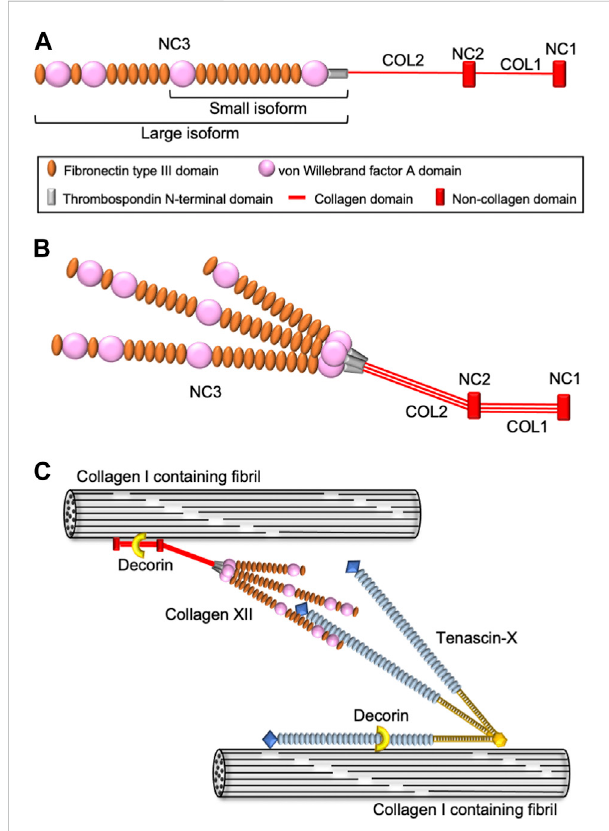
FIGURE 1 Schematic diagram of collagen XII structure and molecular interactions. (A) DomainstructureofcollagenXII.CollagenXIIconsists of two short triple helical domains (COL1 and COL2) separated by non-collagenous domains (NC1 and NC2) and large amino- terminal non-collagenous domains (NC3). NC3 is composed of a thrombospondin N-terminal domain (TSPN), four von Willebrand factor A domains, and 18 fi bronectin type III repeats. (B) The heterotrimeric structure model of collagen XII consisting of two large isoforms(XIIA)andoneshortisoform(XIIB). (C) Hypotheticalmodelfor collagen XII extracellular interaction with other ECM molecules. Collagen XII interacts with the collagen I-containing fi bril surface via its collagenous domain. Decorin might involve in this interaction in a glycosaminoglycan dependent manner. Large NC3 domain of collagen XII interact with tenascin-X, which binding to collagen I-containing fi brils is mediated by